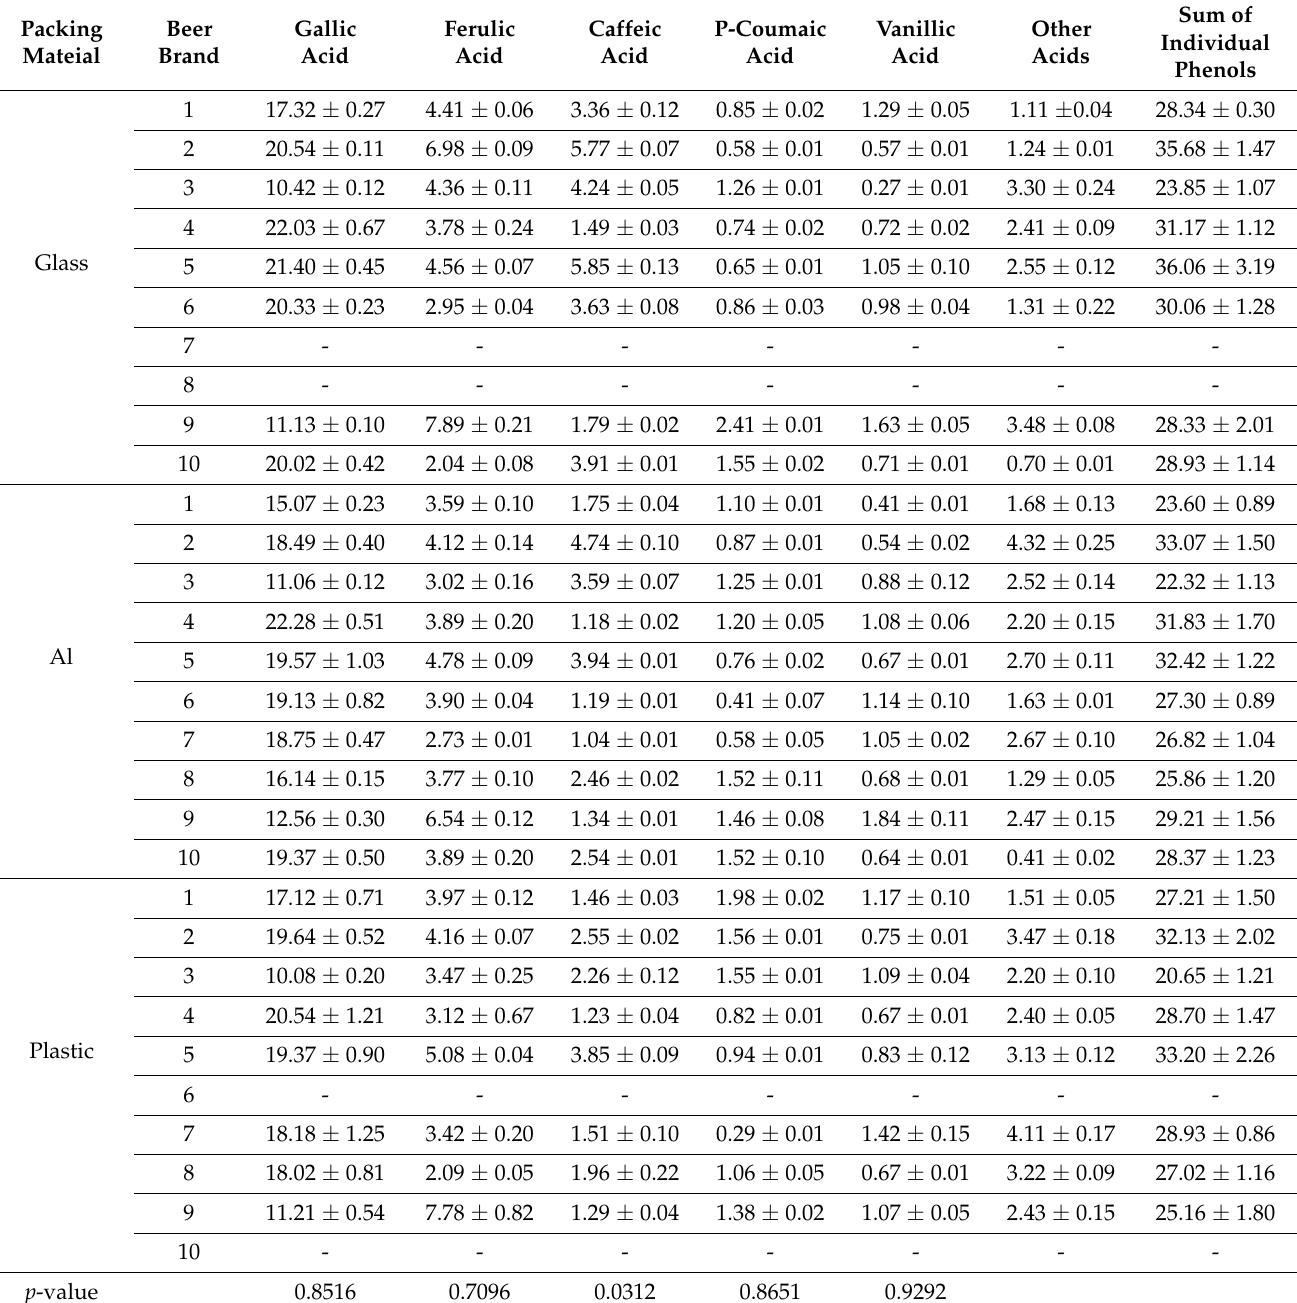
Table 1. Individual phenolic